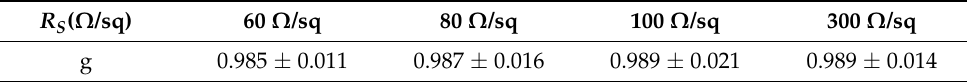
Table 2. Scattering anisotropy factor (g) for the different samples